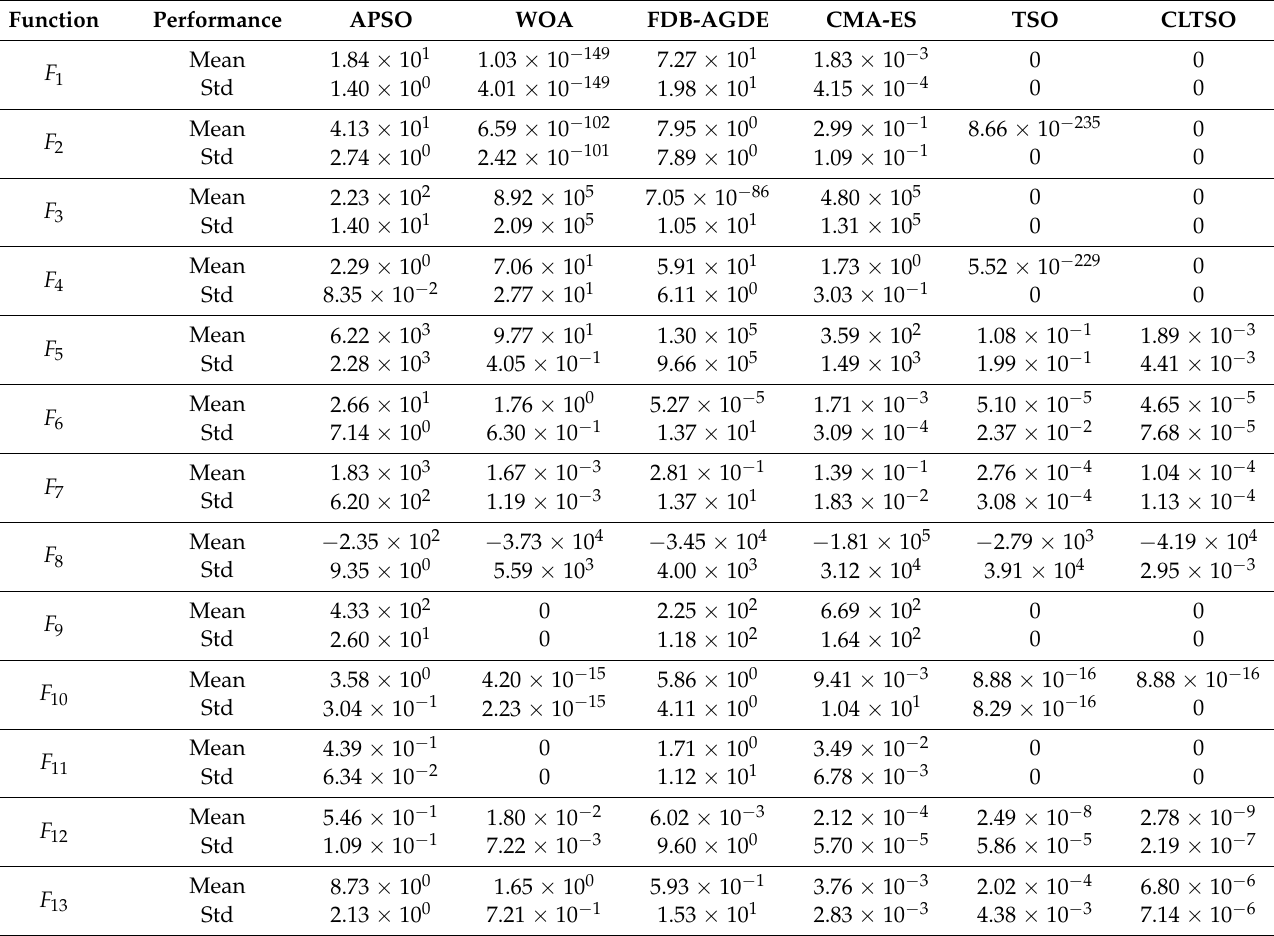
Table 5. Experimental results in 100 dimensions.